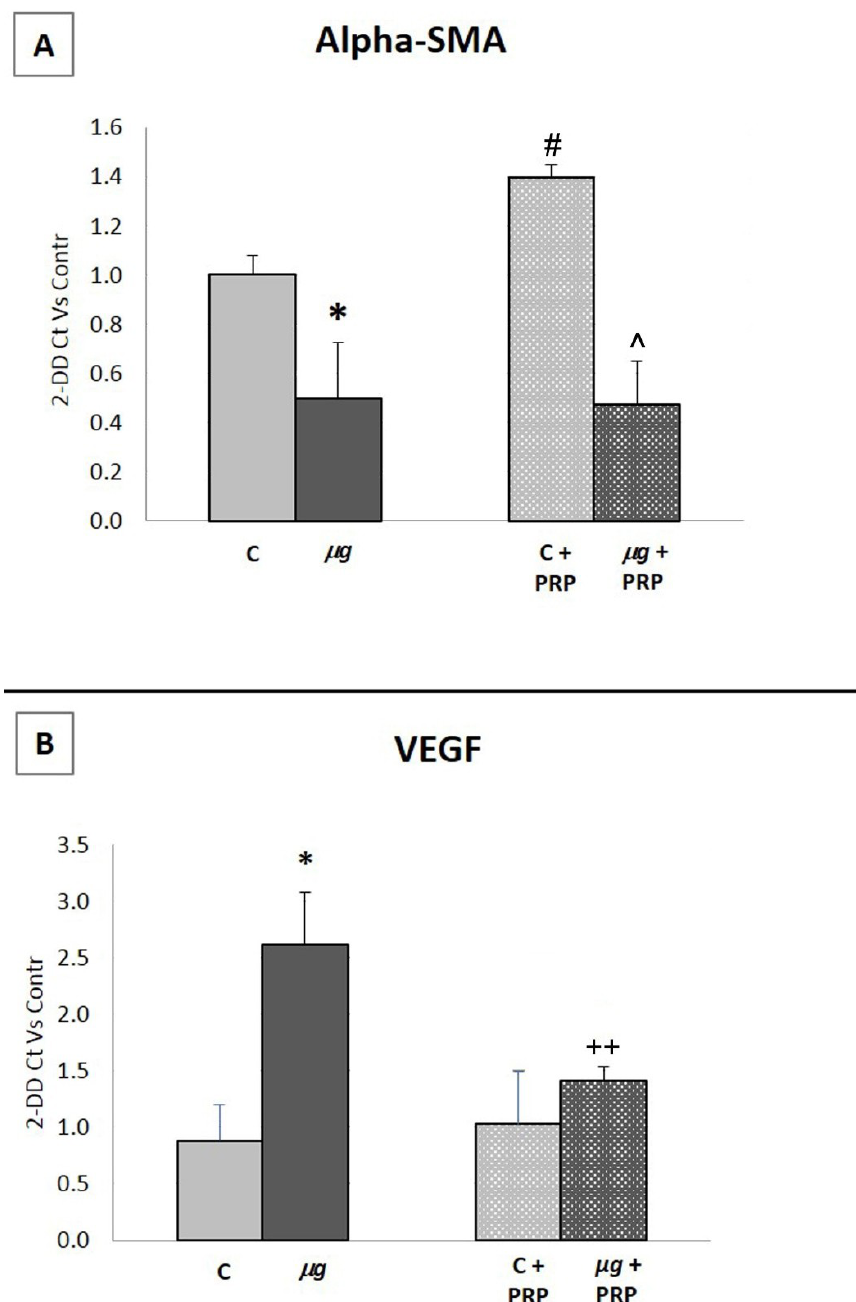
Figure 11. E ff ect of PRP treatment on α -smooth muscle actin ( α -SMA) and vascular endothelial growth factor (VEGF) expression in NIH-3T3 cells exposed to modeled µ g . Expression of α -SMA ( A ) and VEGF ( B ) assessed by real time PCR on total RNA from 1 × g (controls) and µ g -exposed cell samples Figure 11. Effect of PRP treatment on α-smooth muscle actin (α-SMA) and vascular endothelial treated / untreated with PRP during the 72 h exposure. C = 1 × g . Data are expressed as 2 - ∆∆ Ct vs 1 × g growth factor (VEGF) expression in NIH-3T3 cells exposed to modeled μg . Expression of α-SMA controls. ( A ) * p < 0.05 vs. C, # p < 0.05 vs. C, ˆ p < 0.05 vs. C + PRP; ( B ) * p < 0.05 vs. C, ++ p < 0.05 vs. µ g, ( n =